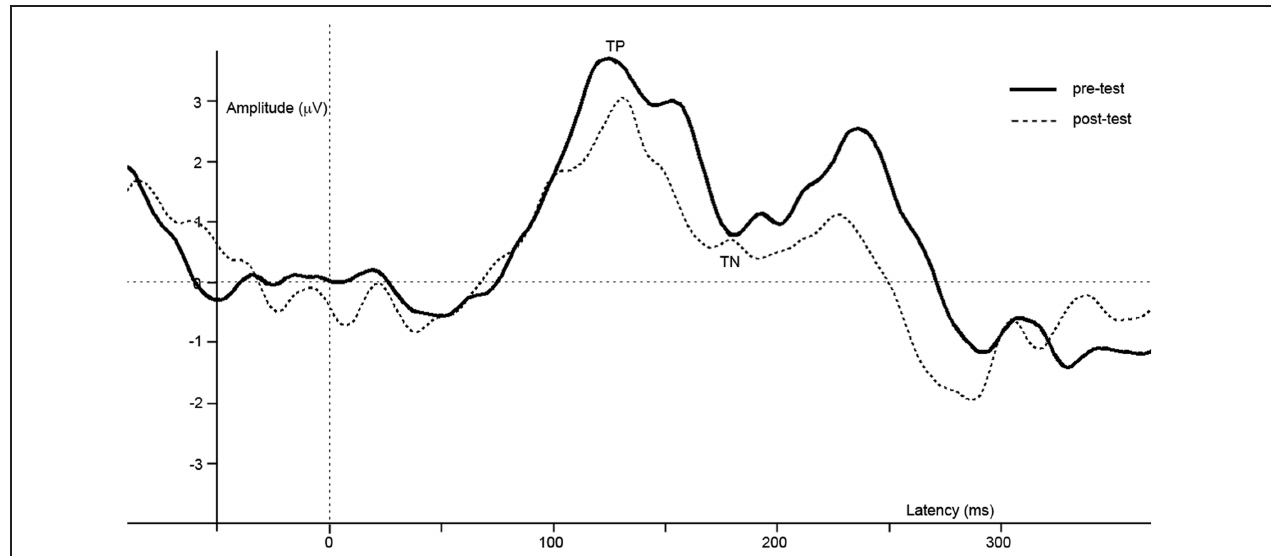
FIGURE 5 | Difference waves of grand averages at Oz electrode evoked by checkered vs. homogeneous stimuli in the pre-test (solid line) and post-test (dashed line) of the control